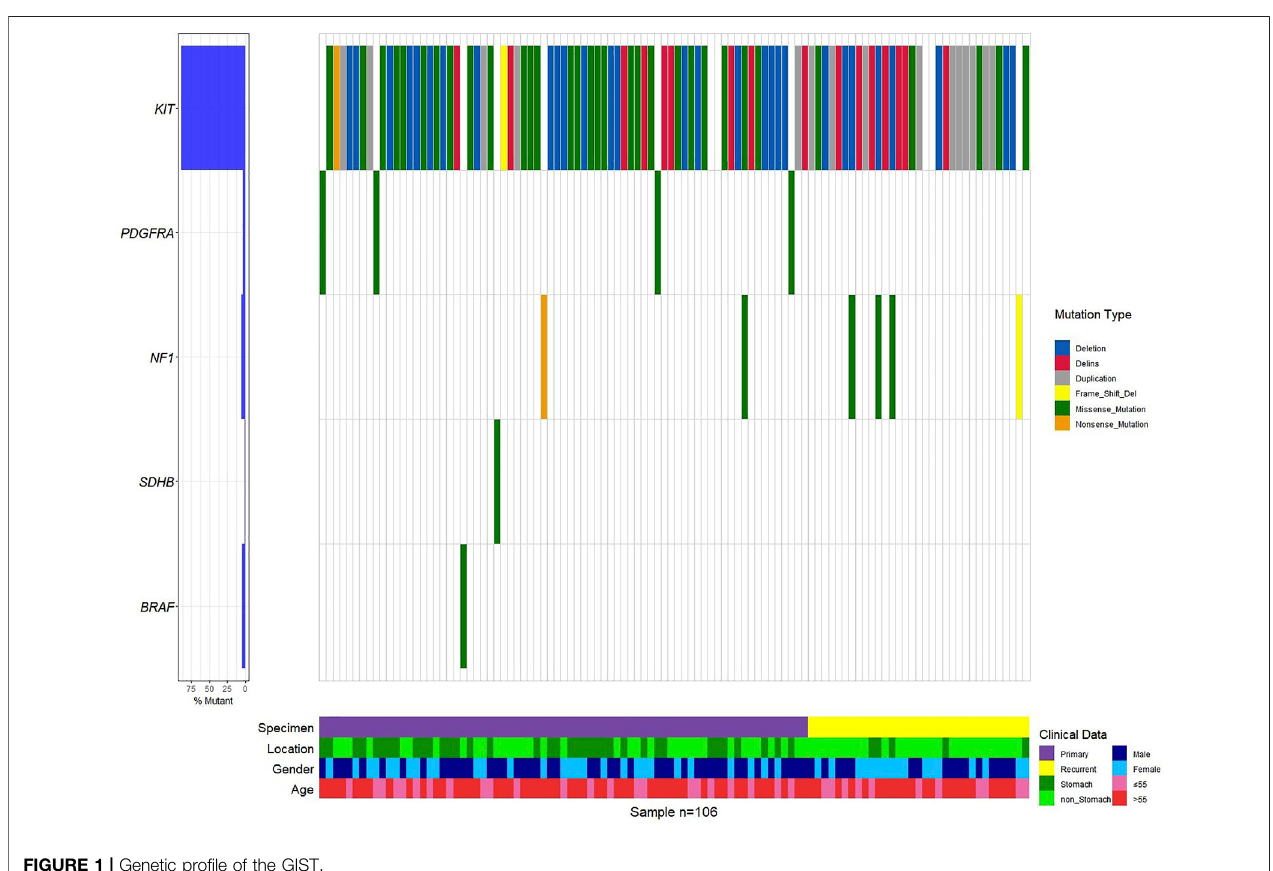
FIGURE 1 | Genetic pro fi le of the GIST.